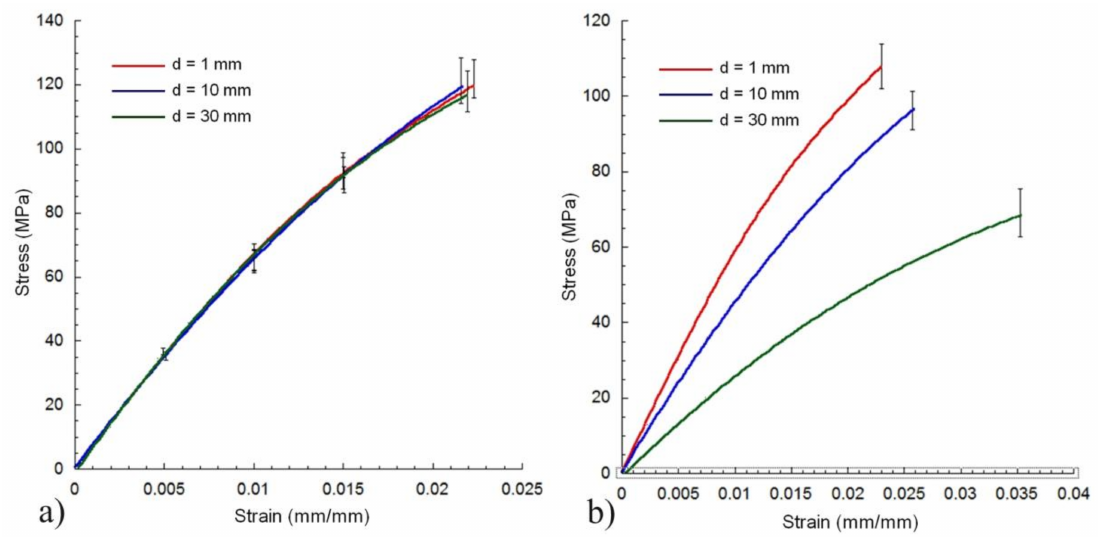
Figure 2. Effect of the distance between the LCU and the restorative composite (EPH) on the bending behaviour/stress–strain curves for laser cured ( a ) and LED cured ( b ) composites. The distance was set at 1, 10, and 30